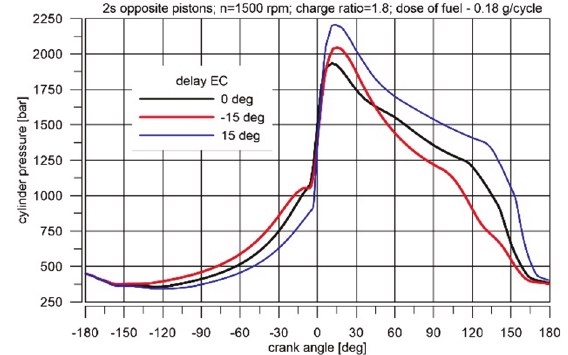
Fig. 12. Temperature course in cylinder for different delays of exhaust port closing